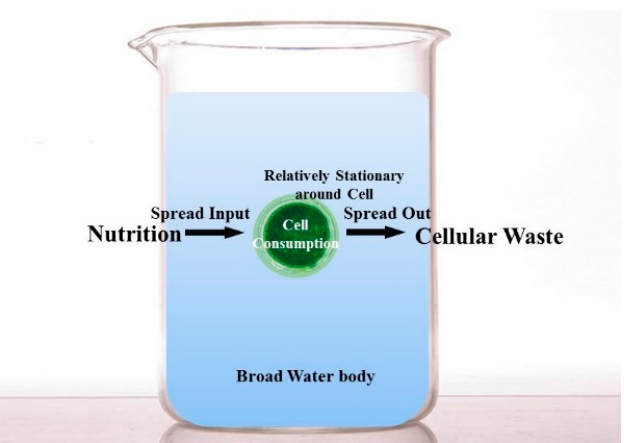
Figure 6. Water mixing can prevent hazardous substances around cell from accumulating and replenish nutrients around the tiny water body.